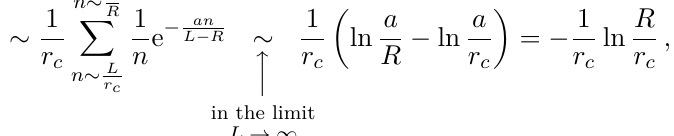
Figure 5 . Casimir energy, calculated numerically (data points) for a = 0 . 1 and two different sets of parameters r c and L . We fitted the analytical approximation − π coefficients c 1 and c 3 , to the numerical result for r c = 150 and L = 150 (blue data points). The resulting function, with such determined coefficients c 1 ’ 3 . 32 and c 3 ’ 0 . 32 , is plotted for r c = 150 (blue curve) and r c = 100 (red